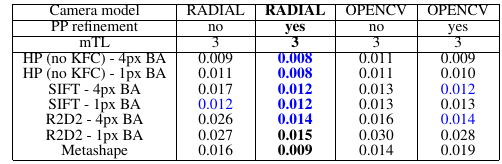
Table 1. RMSEs [m] for different camera setups of the Ven- timiglia Theatre Nadiral dataset.